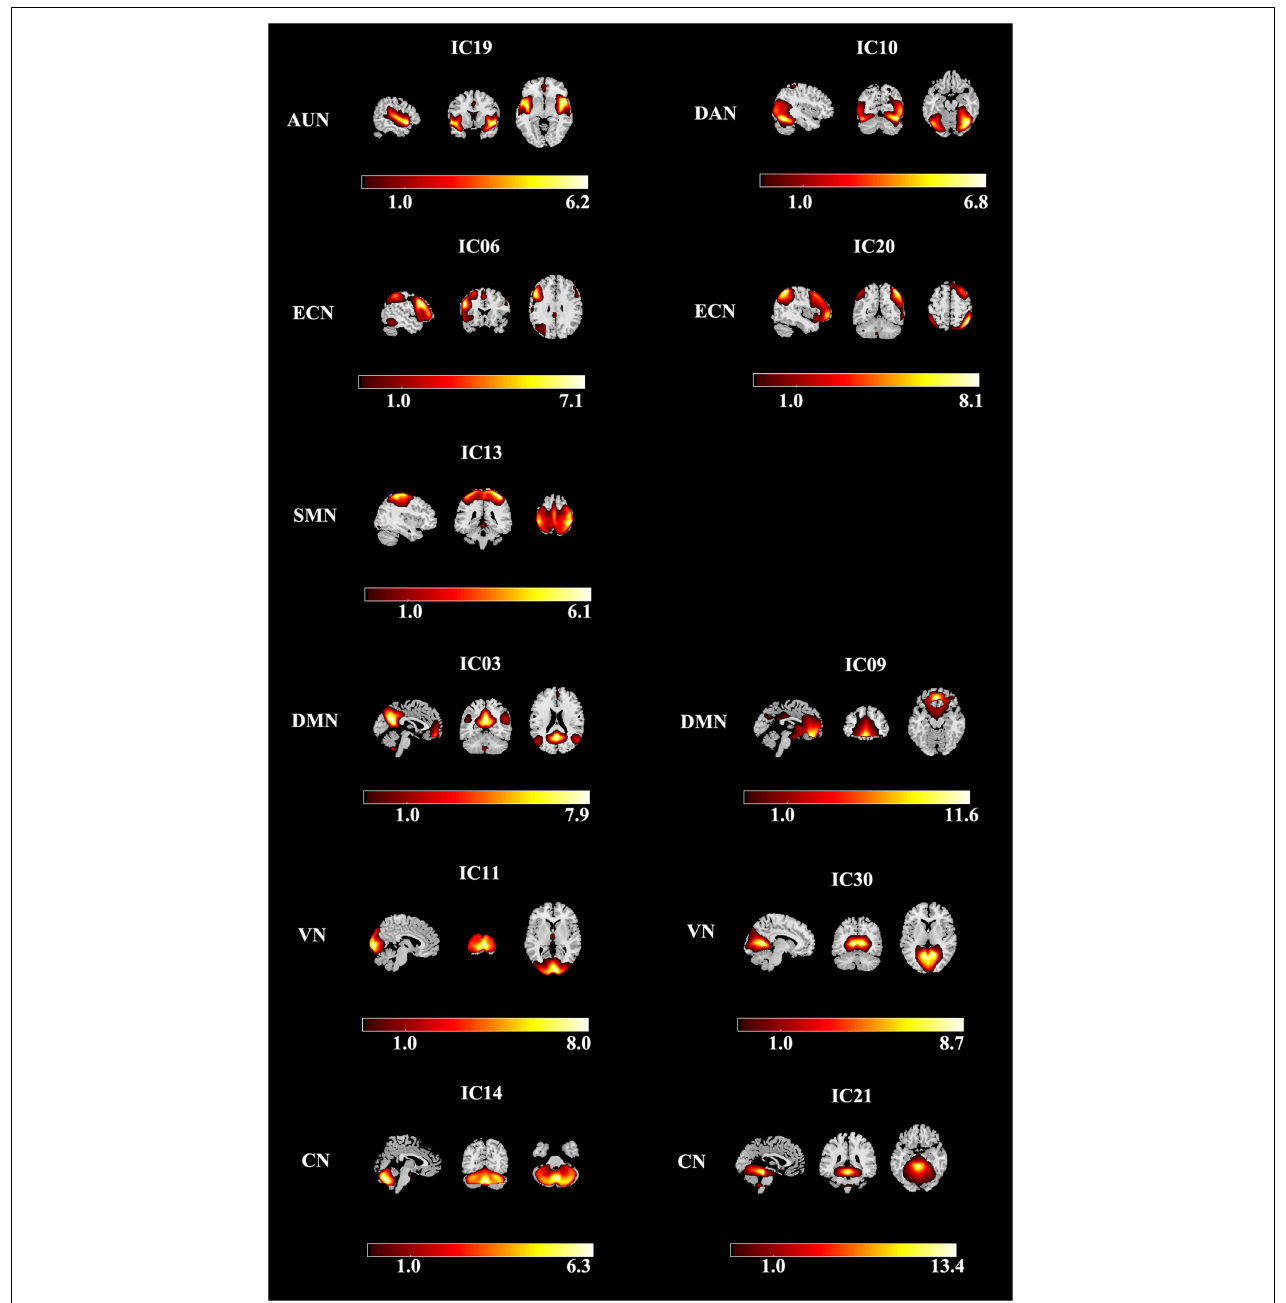
FIGURE 2 | Spatial maps of identified resting-state networks are divided into seven different functional domains, namely, AUN, DAN, ECN, SMN, DMN, VN, and CN. AUN, auditory network; DAN,dorsal attention network; ECN, executive control network; SMN, sensorimotor network; DMN, default mode network; VN, visual network; CN, cerebellum